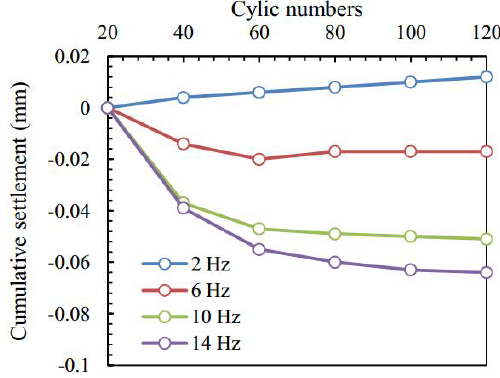
Figure 9. Cumulative settlement with different